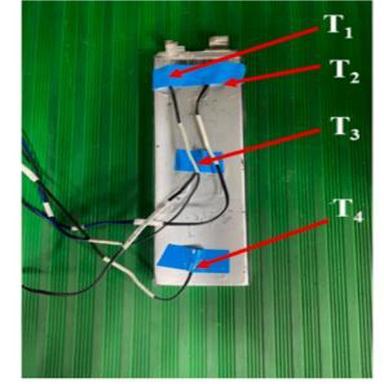
Experimental platform for charge and discharge test.